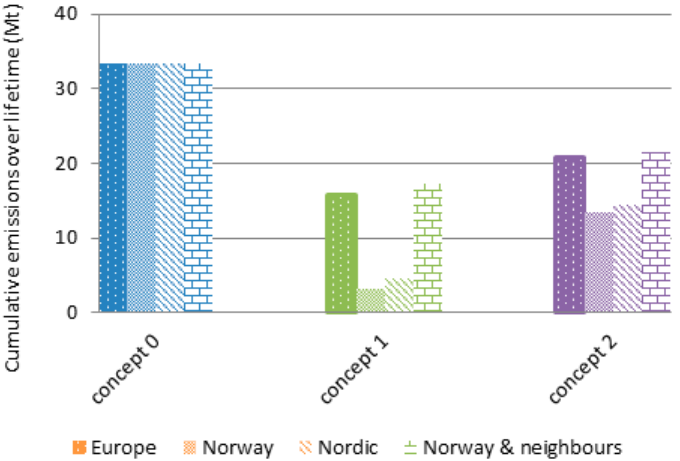
Figure 13. Cumulative CO 2 emissions over the lifetime with the average method from the selected concepts.